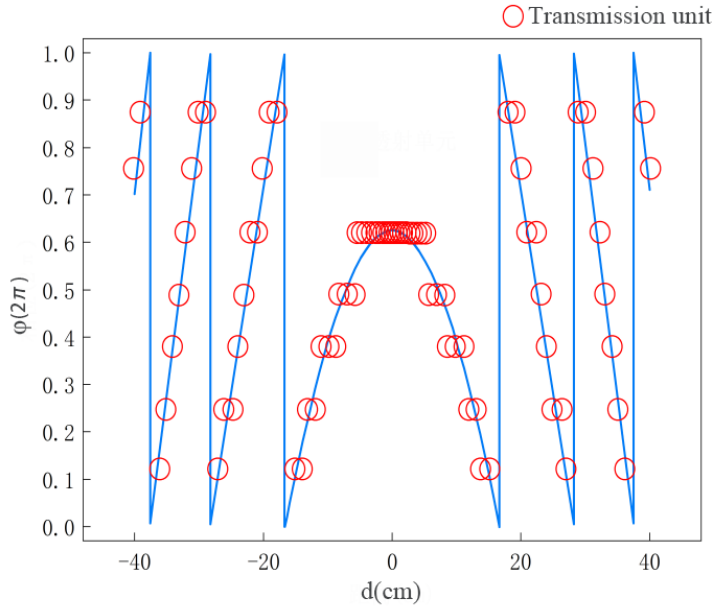
Figure 6. Distribution of transmission units in the y -direction. As can be seen in Figure 6, from y = 40 cm to y = 0 cm, the fluctuating temperature led to the transmission angle having a positive value before gradually decreasing. From y = 0 cm to y = − 40 cm, the fluctuating temperature led to the opposite effect. On the y -axis, the transmission angle at both ends was larger, and the transmission angle in the middle was smaller, forming a gradient distribution of transmission angle on the y -axis. By establishing a model in COMSOL software and setting the parameters and bound- ary conditions, the acoustic pressure and acoustic intensity distribution of the transmitted wave focusing under a discrete temperature gradient could be obtained, as shown in Figures 7 and